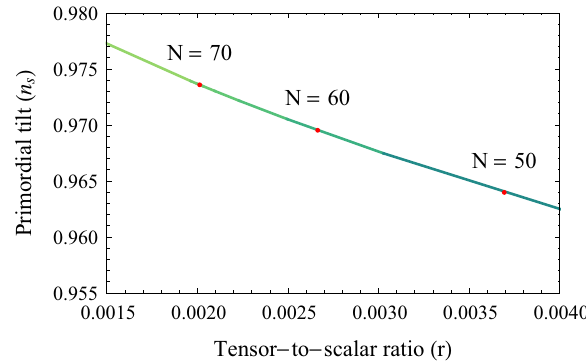
Fig. 4 Thepredictedvaluesofthe r and n s fordifferent e -foldings.The different values of the r and n s are compatible with the observational